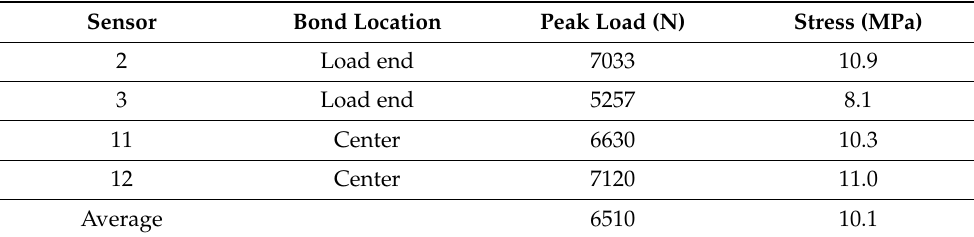
Table 3. Peak load achieved for each sensor coupon test.